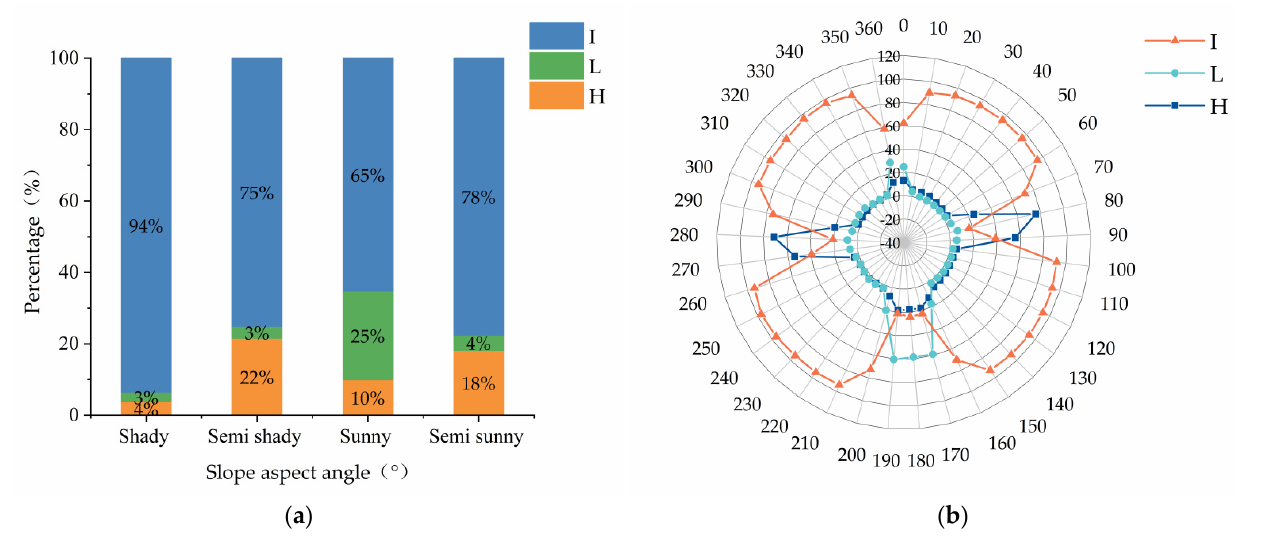
Figure 5. ( a ) Area-proportion map of all cultivated-land ridge orientations with respect to different slope aspects. ( b ) Proportion map of cultivated-land area with different ridge orientations with re- spect to different slope aspects, where: I, inclined ridge; L, longitudinal ridge; and H, horizontal